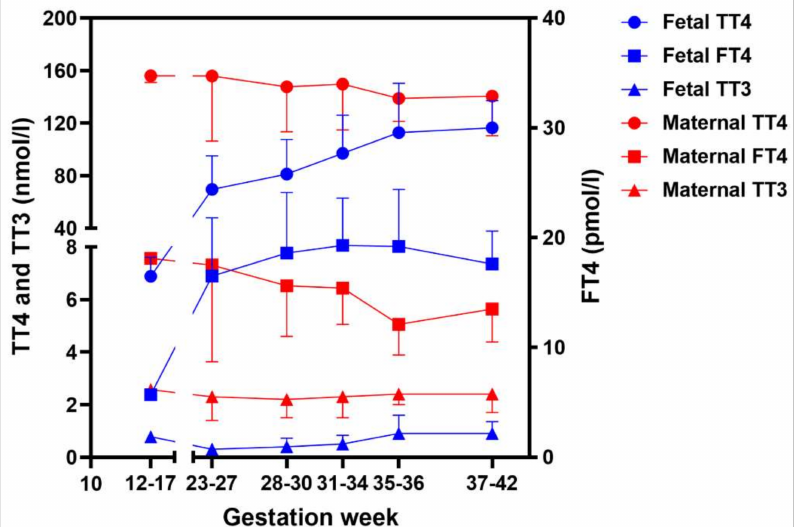
Figure 1. Thyroid hormone levels in maternal and fetal serum during different gestational ages. Data at gestational weeks 12–17, depicted as mean ± SEM, were collected from Calvo et al. [97], which measured concentrations of (free) thyroid hormone and binding proteins in first trimester in amniotic fluids and fetal serum. The other data, depicted as mean ± SD, were from Hume et al. [100], which measured concentrations of (free) thyroid hormone and thyroxine-binding protein during the second and third trimesters in cord blood and the mothers. Note: the data of maternal and fetal FT4 was depicted on the y-axis. TT4: total T4; FT4: free T4; TT3: total